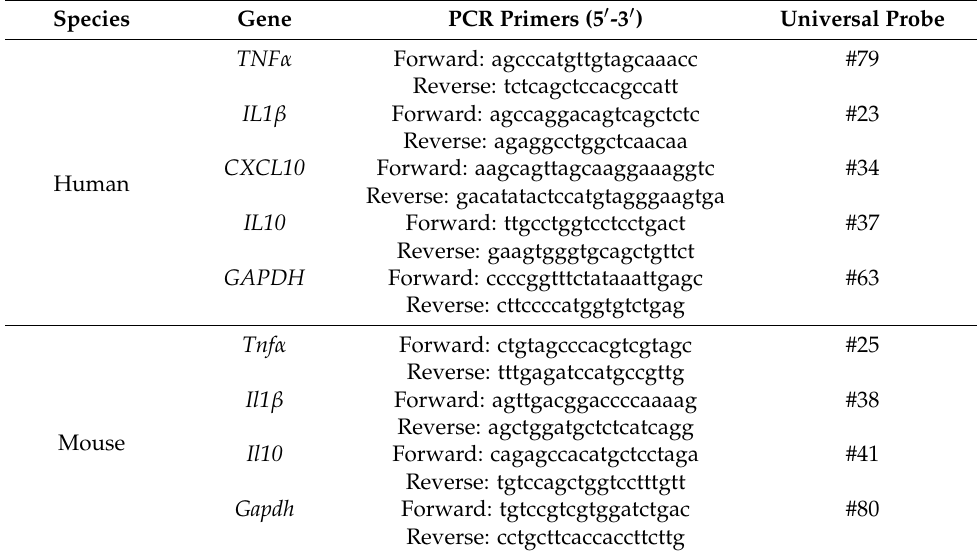
Table 2. Primers and probes for RT-PCR analyses in this study. Species Gene PCR Primers (5 (cid:48) -3 (cid:48) ) Universal